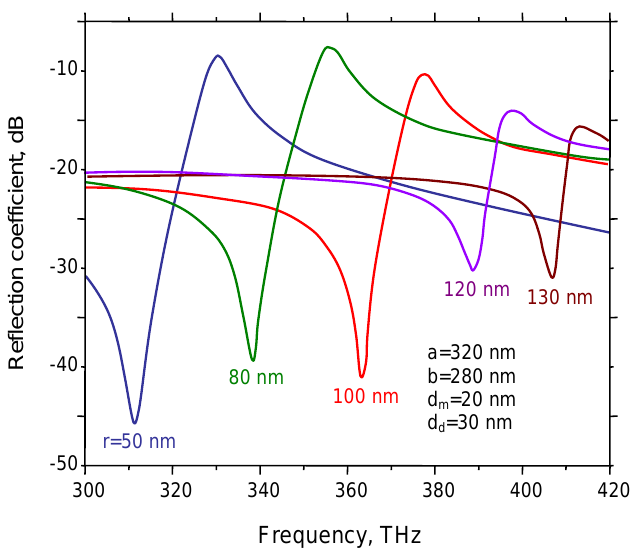
Figure 13. Influence of hole radius on the spectral reflection of the metal-dielectric-metal fishnet